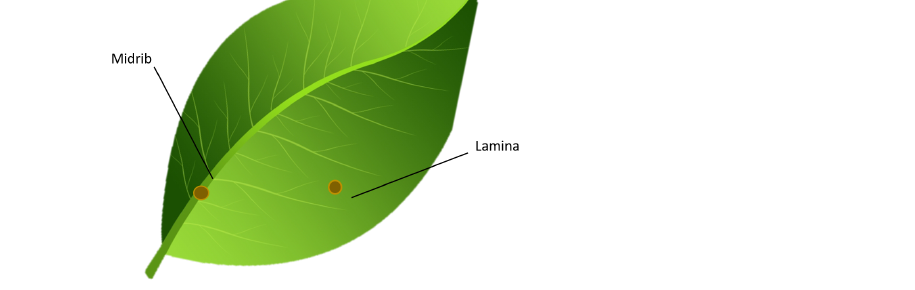
Figure 6. Major misclassifications occur when the leaf symptom is along the midrib or